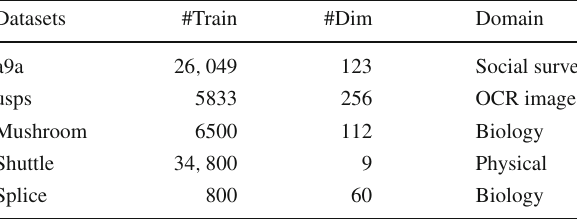
Table 1 Statistics of experimental